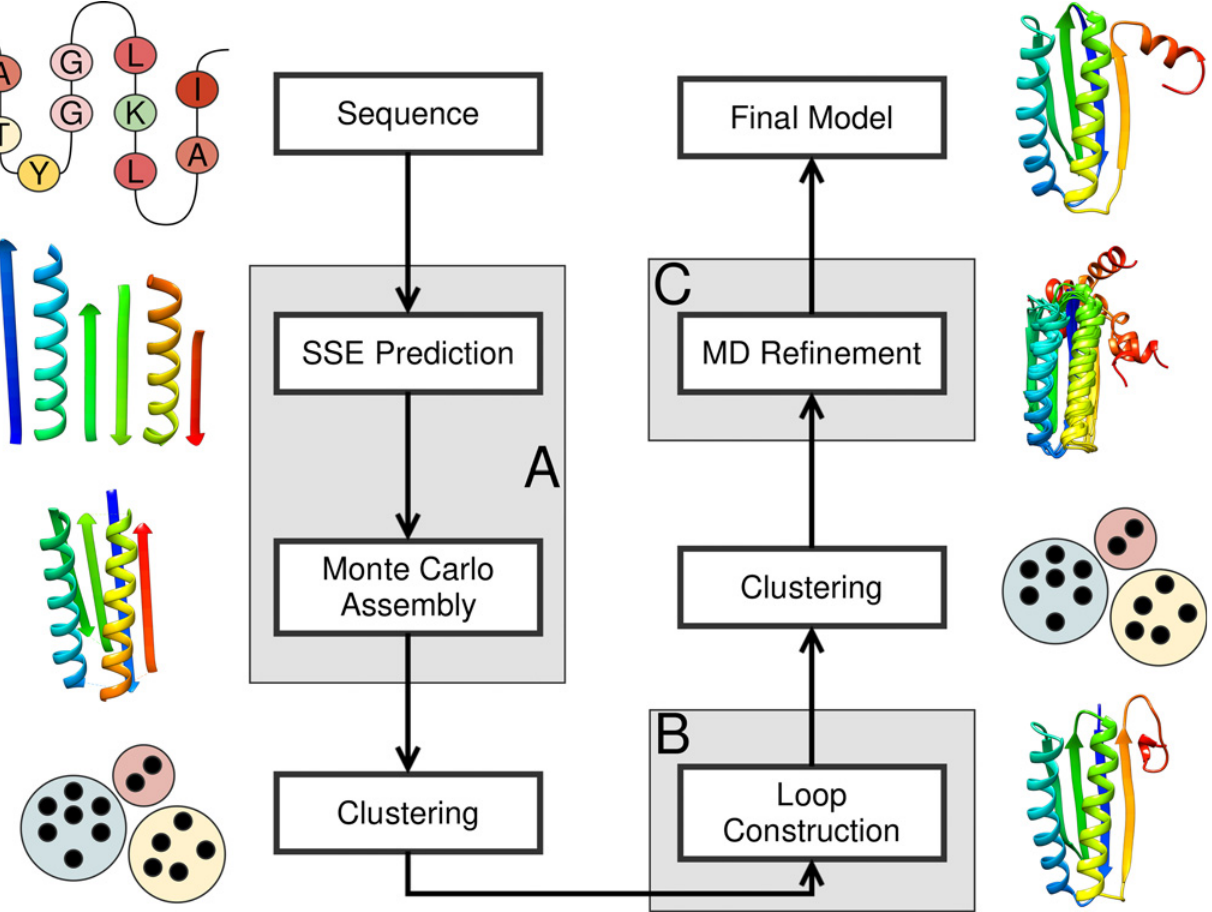
Fig 1. Protein structure prediction pipeline. The protein structure prediction pipeline employed in this study consisted of three modules – low-resolution topology search (A), high-resolution refinement and loop construction (B), and MD refinement (C). (A) The low-resolution topology search is based on BCL:: Fold and uses machine learning algorithms to predict the secondary structure elements (SSEs) of the protein, which are subsequently arranged in the three- dimensional space using a Monte Carlo Metropolis algorithm. (B) High-resolution refinement and loop construction takes place using Rosetta ’ s cyclic coordinate descent algorithm followed by model relaxation. (C) Molecular dynamics simulations were conducted using the Amber package.